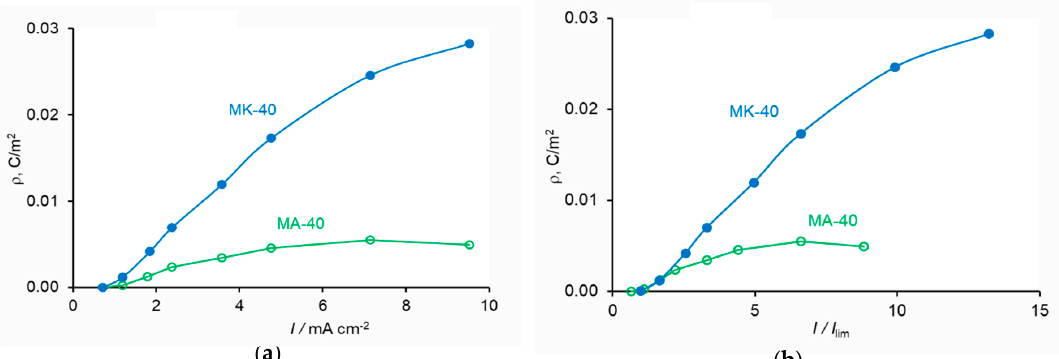
Figure 5. The extended space charge surface density as a function of the applied current density ( a ) and the I / I lim ratio ( b ), for the AEM and CEM. Numerical calculation.